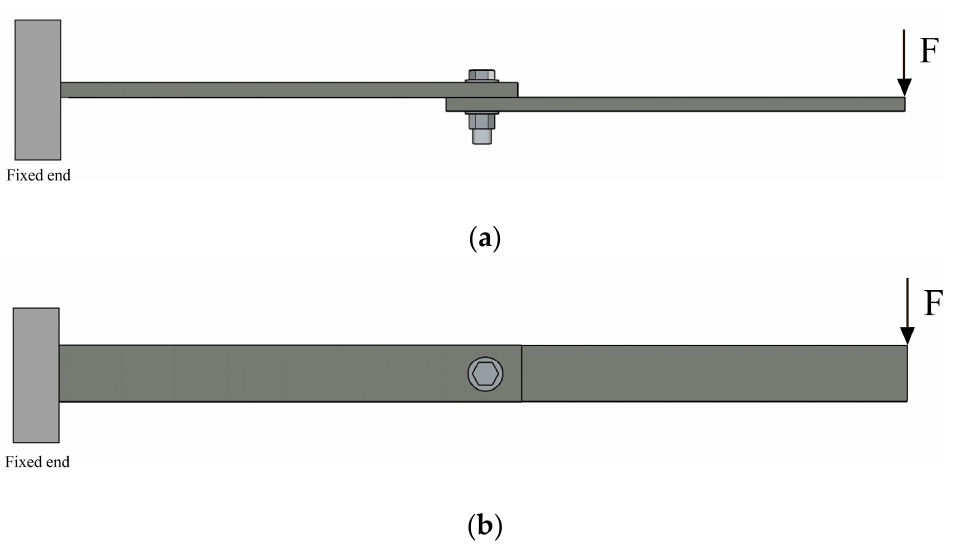
Figure 1. The cantilevered bolt‑jointed beam. ( a ) The load is parallel to the bolt axis; ( b ) The load is perpendicular to the bolt axis.